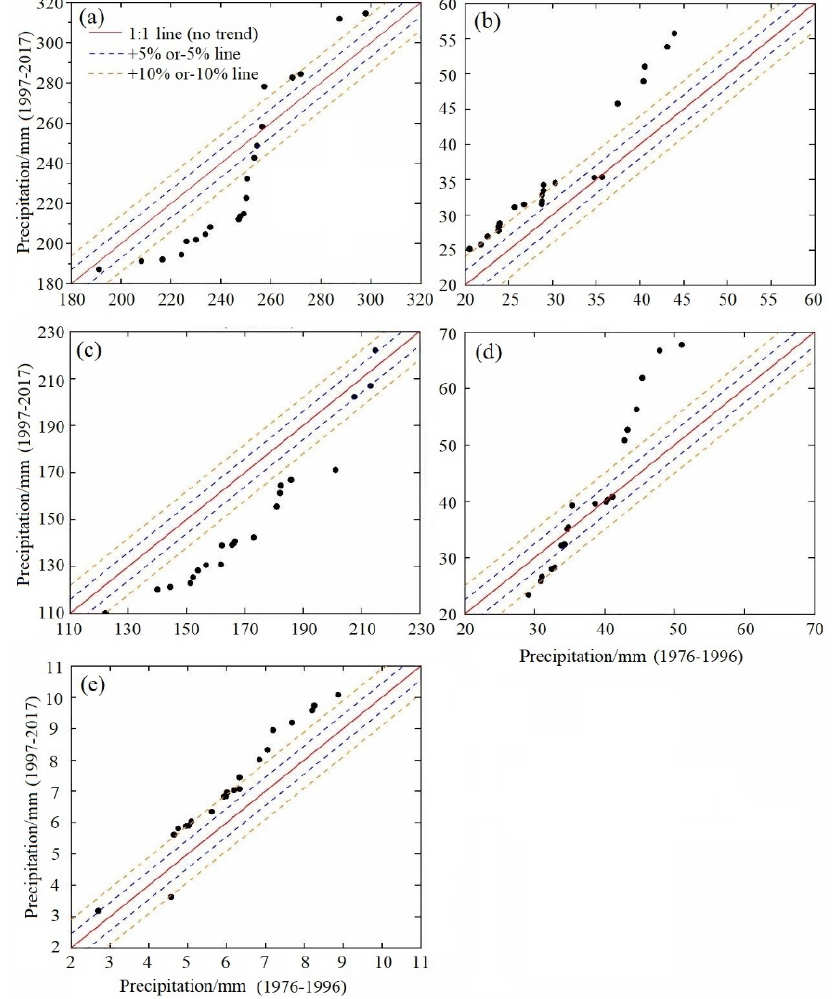
Figure 3. The innovative trend analysis for annual and seasonal precipitation during 1976–2017 in the Mongolian Plateau (( a ) Annual, ( b ) Spring, ( c ) Summer, ( d ) Autumn, ( e ) Winter). A solid red line indicates no trend, a dotted blue line indicates 95% significance, and a dotted yellow line indicates 90% significance).